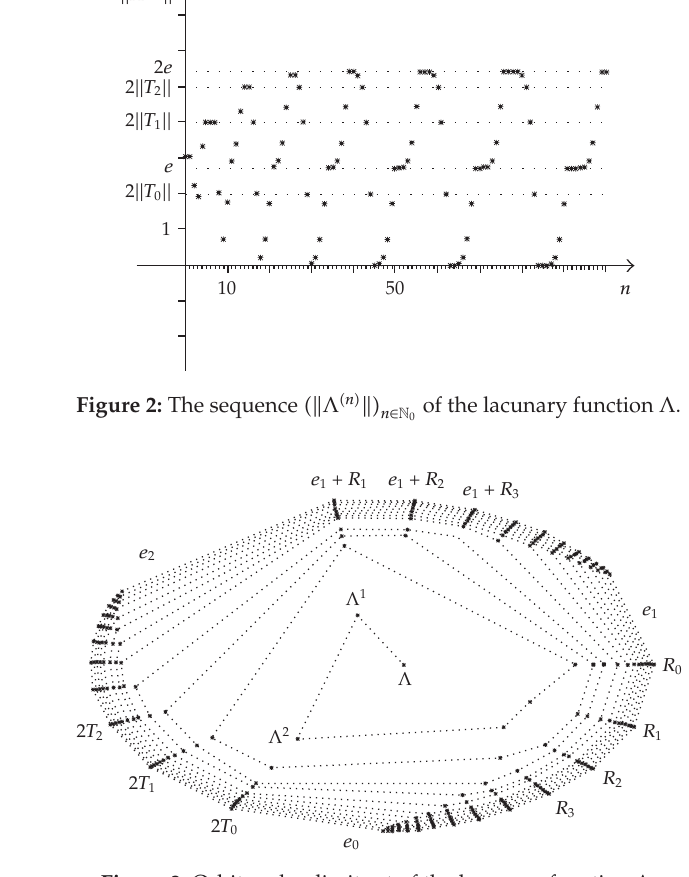
Figure 3: Orbit and ω -limit set of the lacunary function Λ